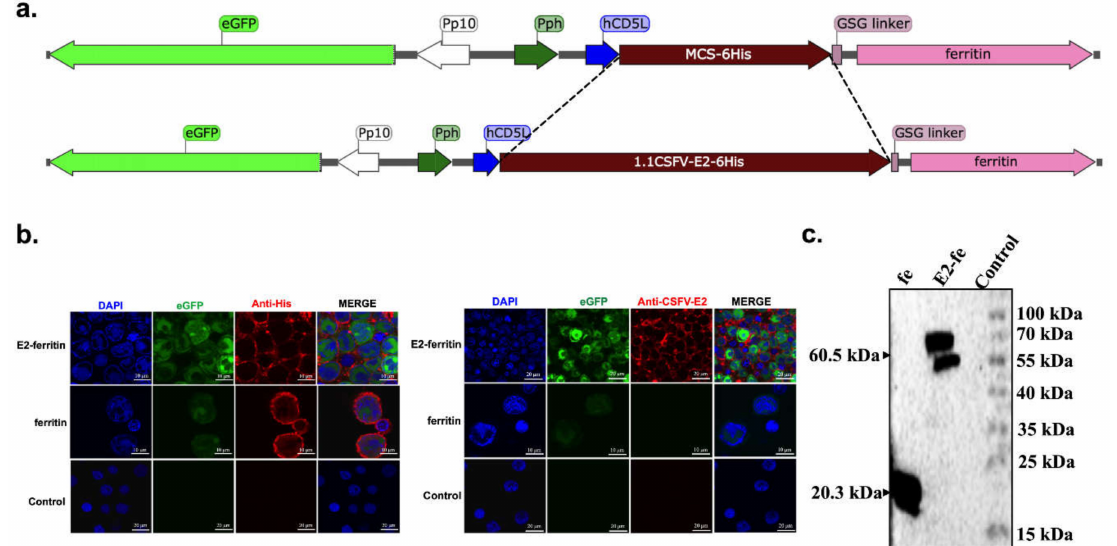
Figure 1. Characterization and intracellular localization of the E2-ferritin and ferritin nanoplatform. ( a ) Schematic represen- tation of the ferritin (above) and E2-ferritin (below) nanoplatform expression cassette. ( b ) Immunofluorescence assay (IFA) for nanocage intracellular location using anti-His tag antibody (left) and anti-CSFV E2 mAb (right) as primary antibodies followed by Alexa Fluor 555 as secondary antibody using confocal microscopy. ( c ) Protein expression detected by Western blotting using anti-His tag monoclonal